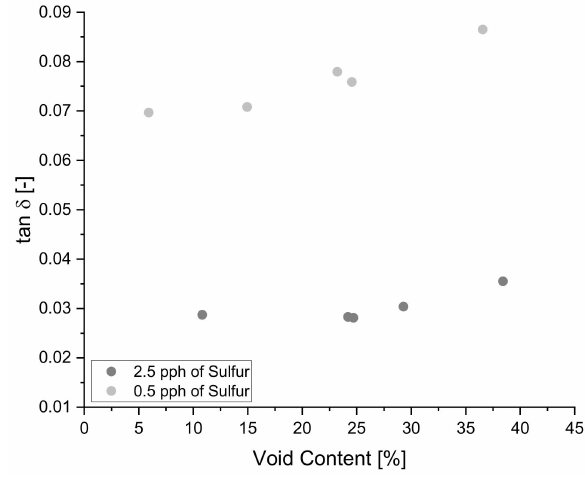
Figure 14. The increasing relationship of void content on tan δ .